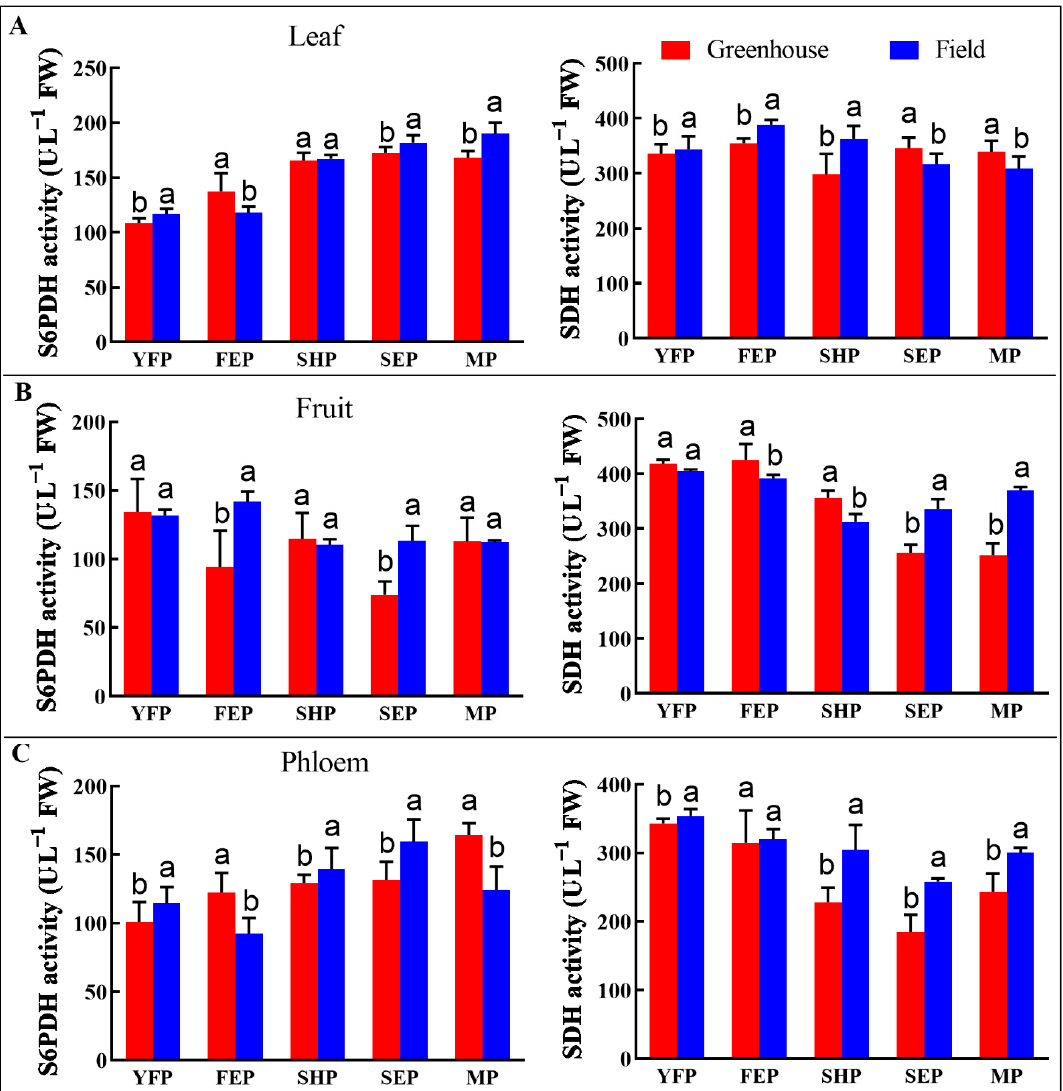
Figure 5. Activities of sorbitol metabolic enzymes in different parts of peach trees grown in the field and greenhouse. ( A – C ) show the activities of sorbitol metabolic enzymes in leaves, fruits and phloem, respectively. These enzymes include S6PDH and SDH. The data are presented as the means ± SDs from three biological replicates. Different lowercase letters indicate significance ( p < 0.05).